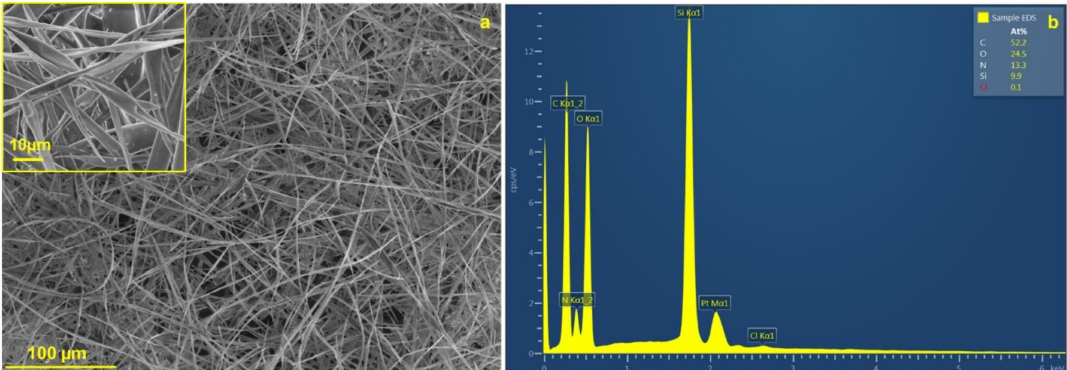
Figure 2. SEM image of the prepared hybrid fibres with an inset showing the helical structure of the